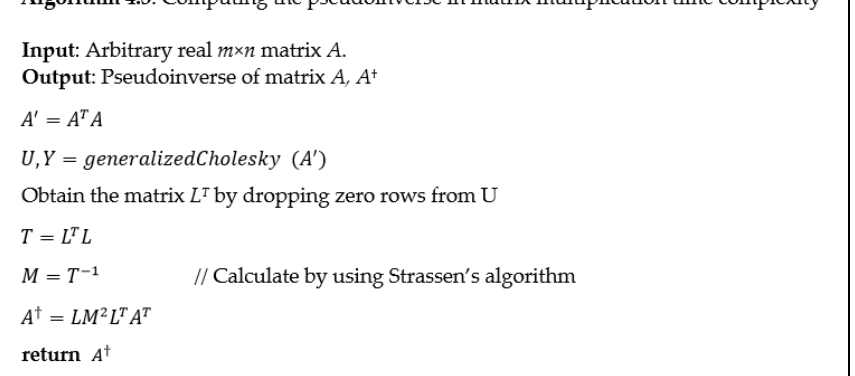
Figure A3. Calculating the pseudoinverse of an arbitrary real matrix.